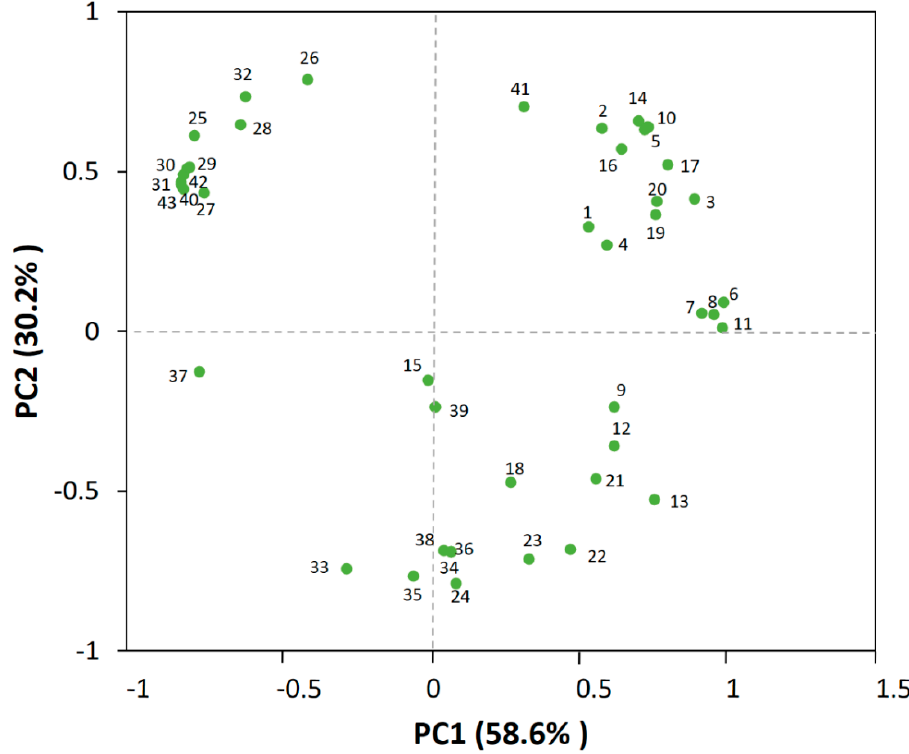
Figure 1. Comparison of the contents of esters ( A ) and alcohols ( B ) of the jujube wine produced by the six winemaking yeasts. Bars with different letters on the top (from a to d) indicate that they have a significant difference from each other. The significance of difference between a and b, c, or d is at a level of 0.001 ( p value); the significance of difference between b and c or between c and d is at a level of 0.05 ( p value); and the significance of difference between b and d is at a level of 0.01 ( p value).